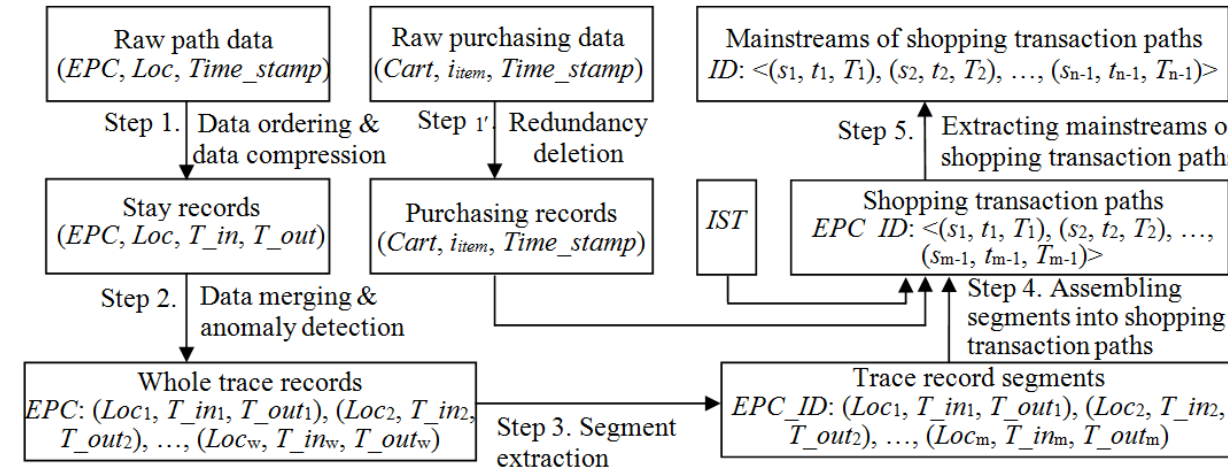
Figure 3. RFID data